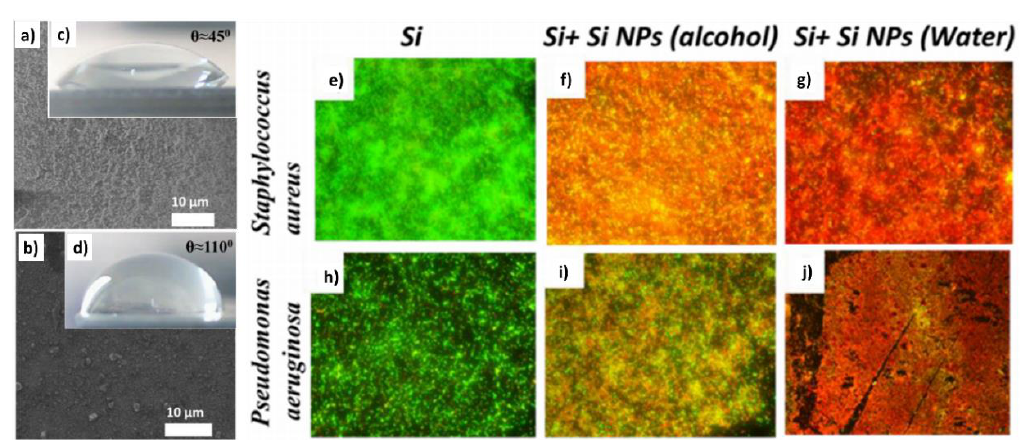
( c ) Figure 4. Summary of the silicon-based nanomaterials used for the treatment of bacterial infection depending on the stage in which they operate. ( a ) Bacteria Detection [86–89,103]. ( b ) Effect on Planktonic Bacteria [86,90–97,100,103]. ( c ) Effect on Biofilm [90,104–107]. 4. Application of Silicon-Based Nanomaterials Synthesized by Laser Ablation for Combating Bacterial Infection In the previous section, many applications were described that silicon-based nanomaterials present to combat bacterial infection. Silicon-based nanomaterials synthesized by laser ablation are structurally analogous and therefore possessors of all of them, with the additional advantage of not using chemical reagents during formation, reducing the potential toxicity in the body. Surprisingly, its use so far is limited. Among the possible stages for the treatment of bacterial infection (detection, action on planktonic bacteria, and action on the biofilm) that can be intervened, the use of silicon- based nanomaterials created by laser ablation, has preferably focused on the creation of anti-adherent surfaces to prevent the biofilm formation. Reason why the present manuscript focuses on describing its usefulness in this stage.